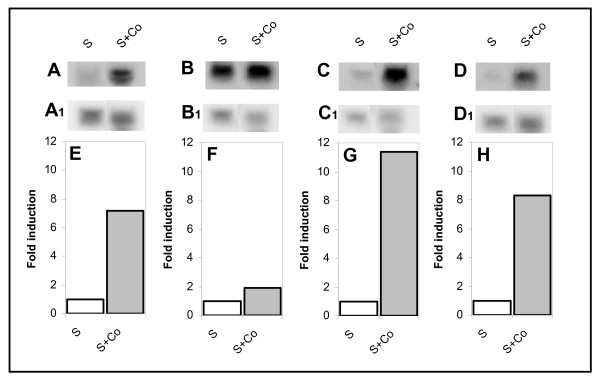
Northern blot analysis of B. emersonii genes encoding enzymes involved in propionyl-CoA metabolism. A, E. Propionyl-CoA carboxylase; B, F. DL-methylmalonyl-CoA-racemase; C, G. Methylmalonyl-CoA mutase; D, H. ATP:Cob(I)alamin adenosyltransferase. The RNA blots were also hybridized with a probe of the hsp70-3 gene, which is not induced by CoCl, as a control (A1-D1). Data from densitometry scanning of the hybridization bands is shown in panels E-H. The values were normalized using the hsp70-3 bands as a control. S = total RNA isolated from cells after 60 min of sporulation; S + Co = total RNA isolated from cells after 60 min of sporulation in the presence of 100 μM CoCl.